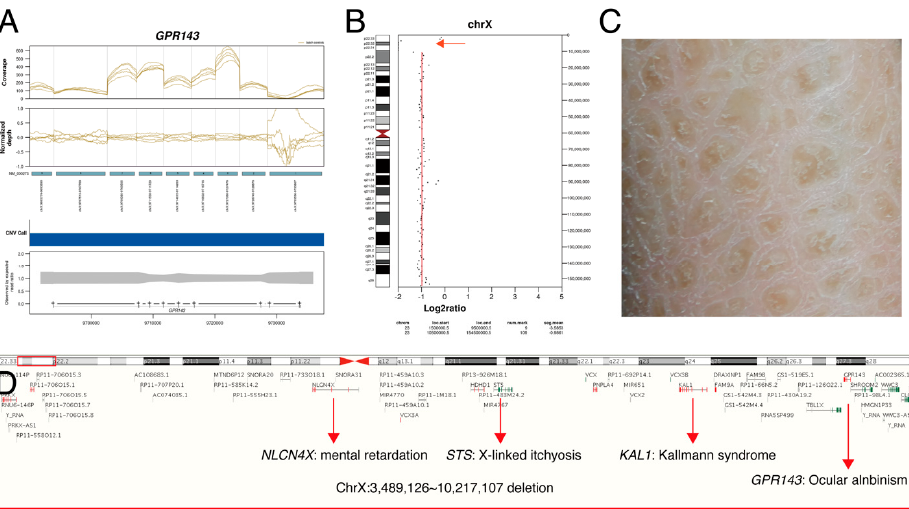
Figure 1. Diagnostic rate of targeted next-generation sequencing (NGS) in inherited eye diseases. ( A ) Overall diagnostic rate of targeted NGS and the proportion of patients who received precision medicine after genetic testing. ( B ) Diagnostic rate of targeted NGS among each disease category.